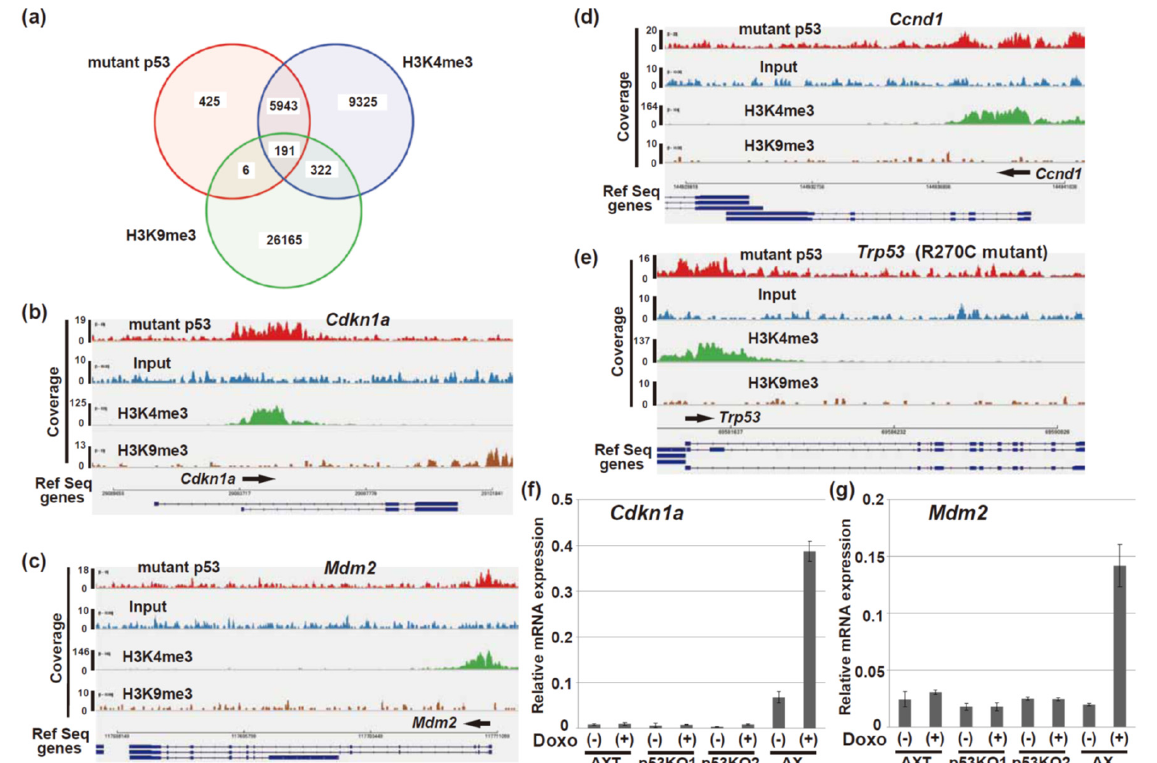
Figure 6. R270C mutant p53 in AXT cells binds to chromatin. ( a ) A Venn diagram illustrating the genomic overlap of peaks in the active regions of p53, H3K4me3, and H3K9me3. The active regions are defined in the Methods Section. ( b , c ) Density plots of the ChIP-seq reads for p53, H3K4me3, and H3K9me3 at the Cdkn1a ( b ) or Mdm2 ( c ) loci. The data are based on the snapshot images taken from analysis using the IGV software. ( d , e ) ChIP-seq occupancy profiles for p53, H3K4me3, and H3K9me3 at the Ccnd1 ( d ) and Trp53 ( e ) loci. ( f , g ) RT and real-time PCR analysis of the Cdkn1a ( f ) and Mdm2